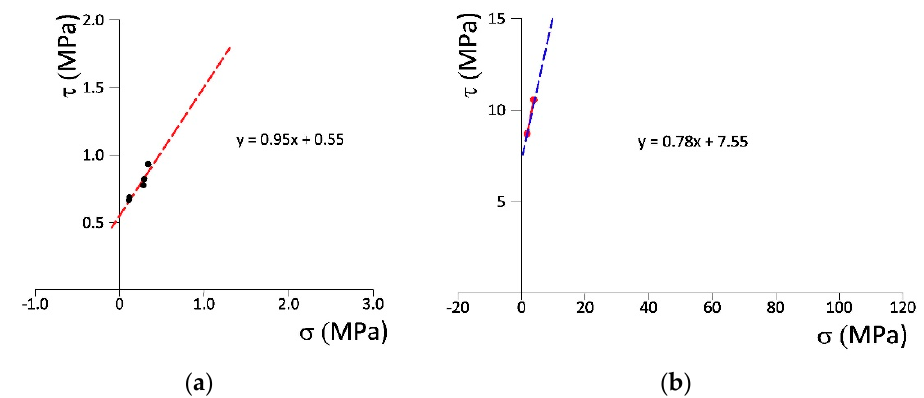
Figure 8. Experimental data points for ( a ) Ytong blocks with compression strength of 3 MPa showing cohesion of 0.55 MPa and ( b ) very high strength concrete blocks with compression strength of 100 MPa, showing cohesion of 7.55 MPa.